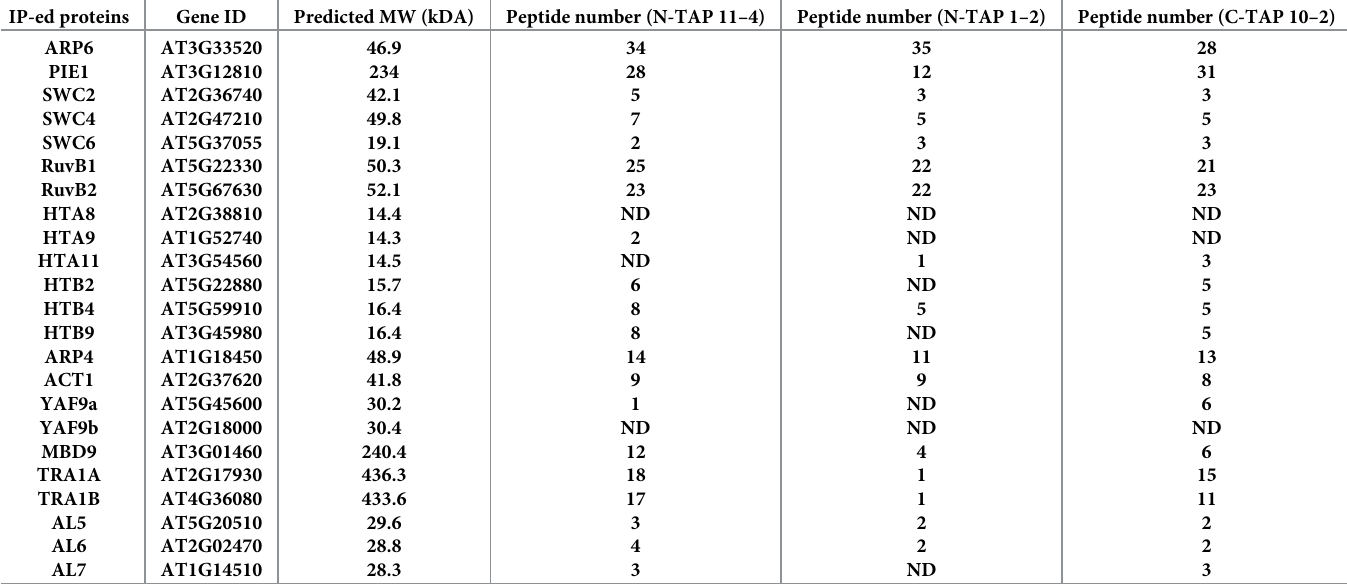
Table 1. Arabidopsis thaliana homologs of SWR1-C subunits co-purify with N-TAP ARP6 and C-TAP ARP6. IP-ed proteins Gene ID Predicted MW (kDA) Peptide number (N-TAP